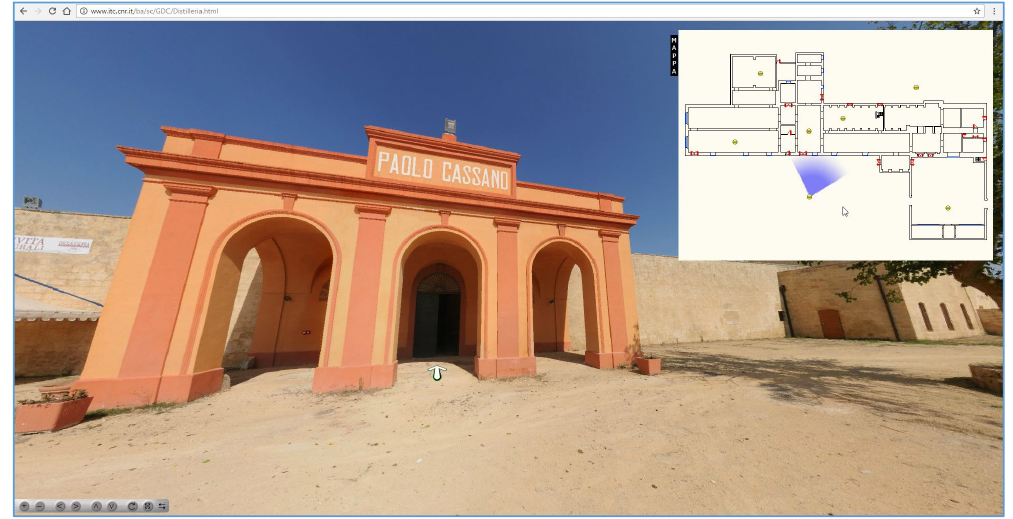
Figure 5. Virtual tour of “Distilleria Cassano”—a 3D multimedia object accessible through the map. It is possible to activate the site’s layout, displaying all the viewpoints of the virtual tour (right).